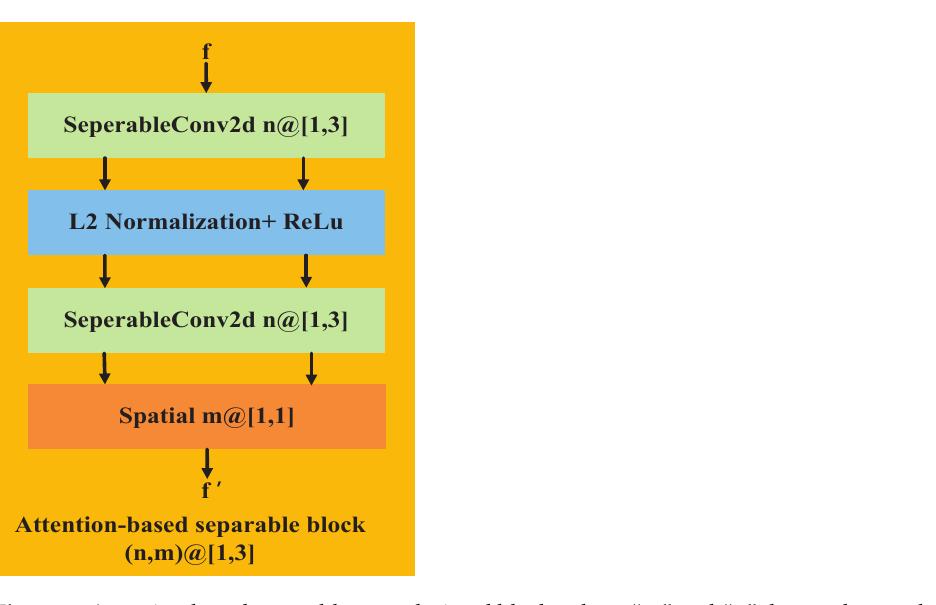
Figure 5. Attention-based separable convolutional block, where “m” and “n” denote the number of input and output channles of depthwise separable convolution, respectively. The “n” also represents the number of input and output channels of spatial